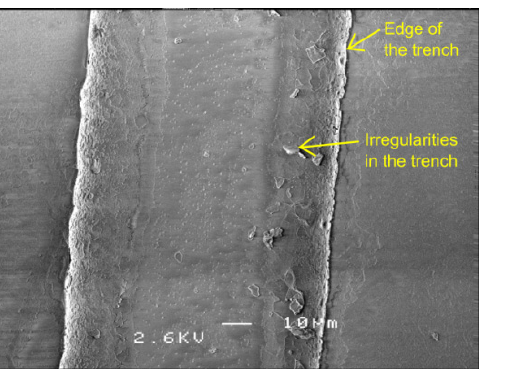
Figure 5. SEM photographs of ( a ) a microchannel and ( b ) an exposed trench (top glass slide removed) detailing the surface topography and roughness of the chemically etched